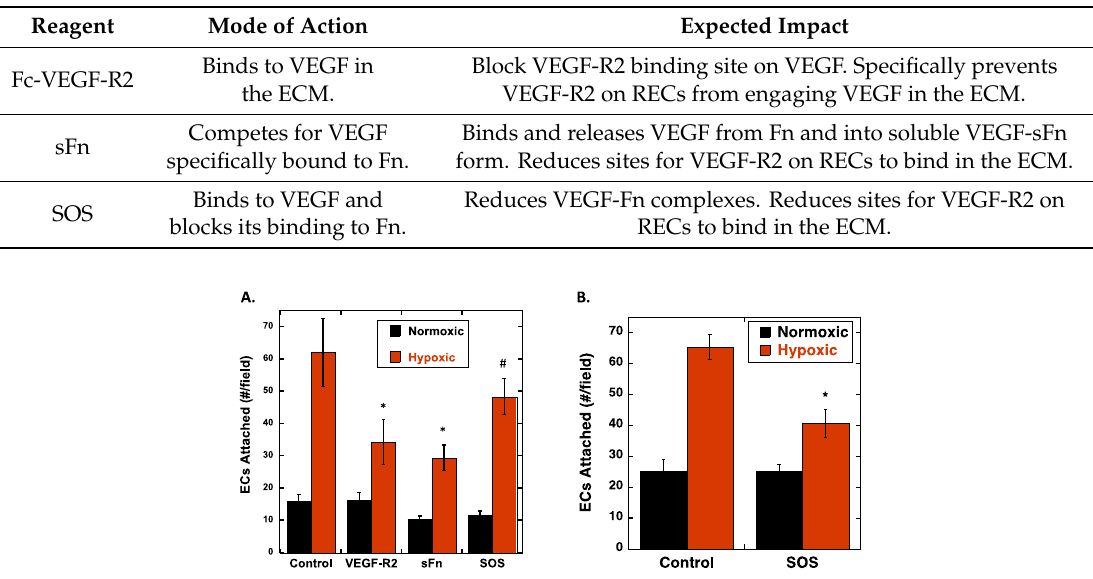
Figure 2. Soluble VEGF-ECM (vascular endothelial growth factor-A-extracellular matrix)